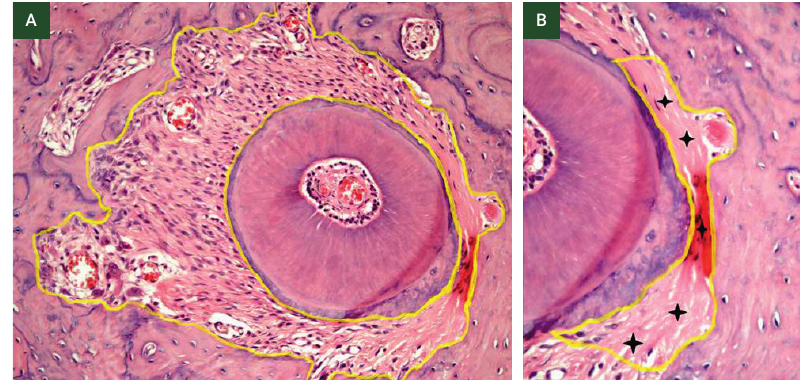
Figure 3. Cross section of distobuccal root (DV) with 3 days of orthodontic movement. A - Section area of the PDL. B - * Periodontal hyaline area (Staining - HE, magnification-40x).